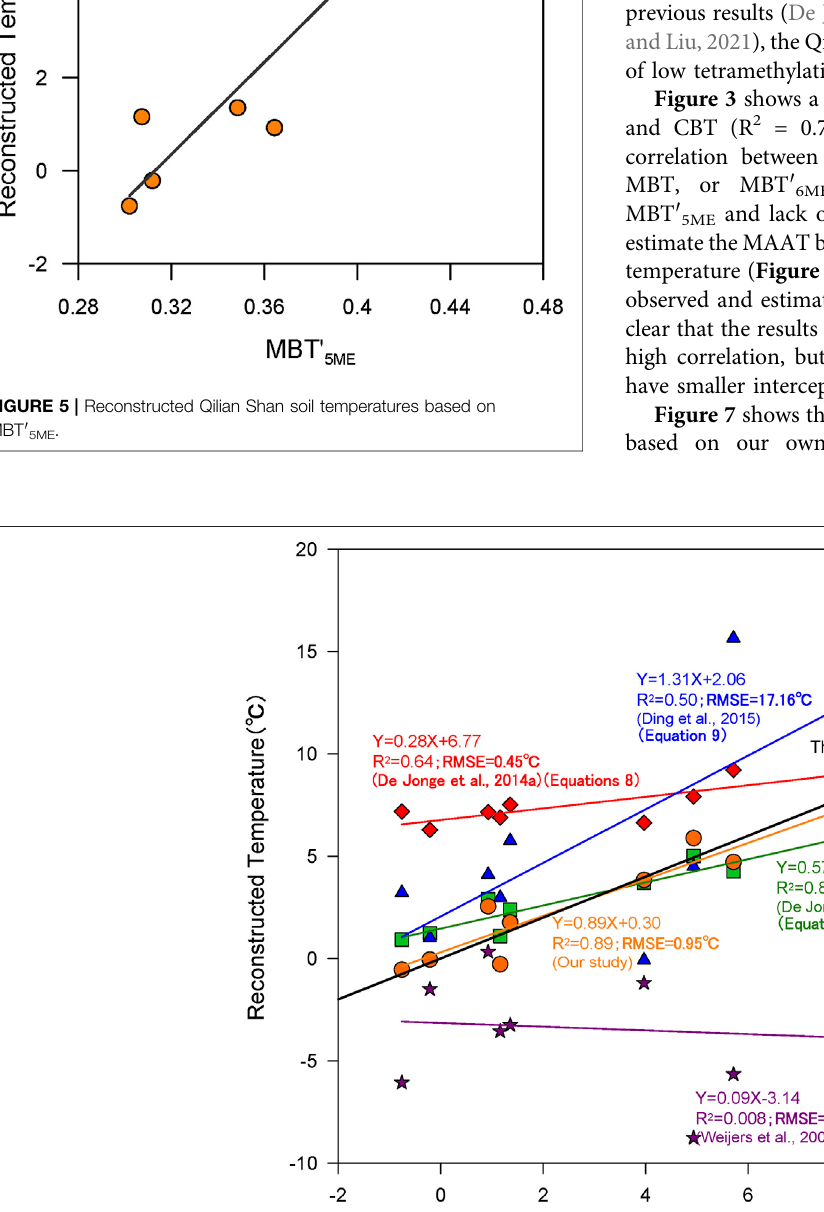
Frontiers in Earth Science |